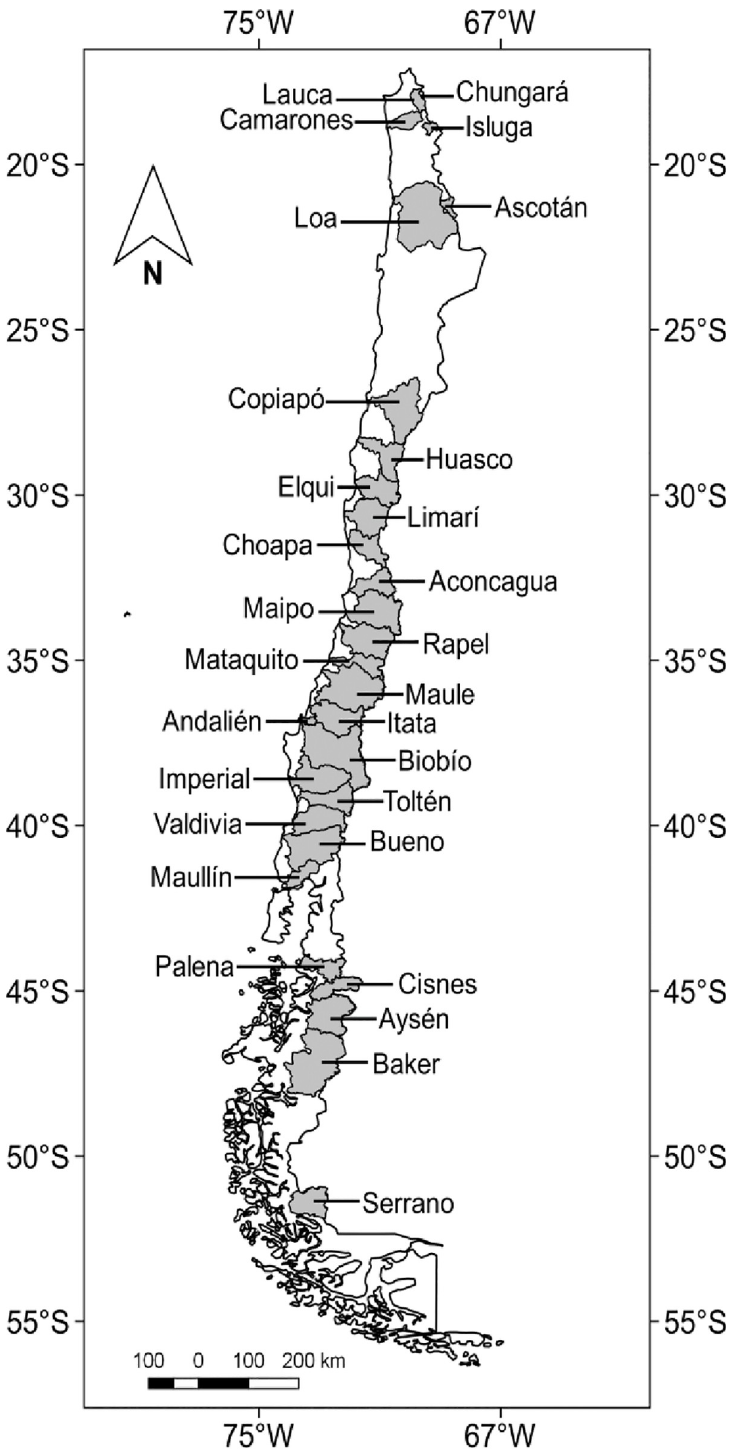
Fig 1. Geographic location of the 29 basins studied in continental